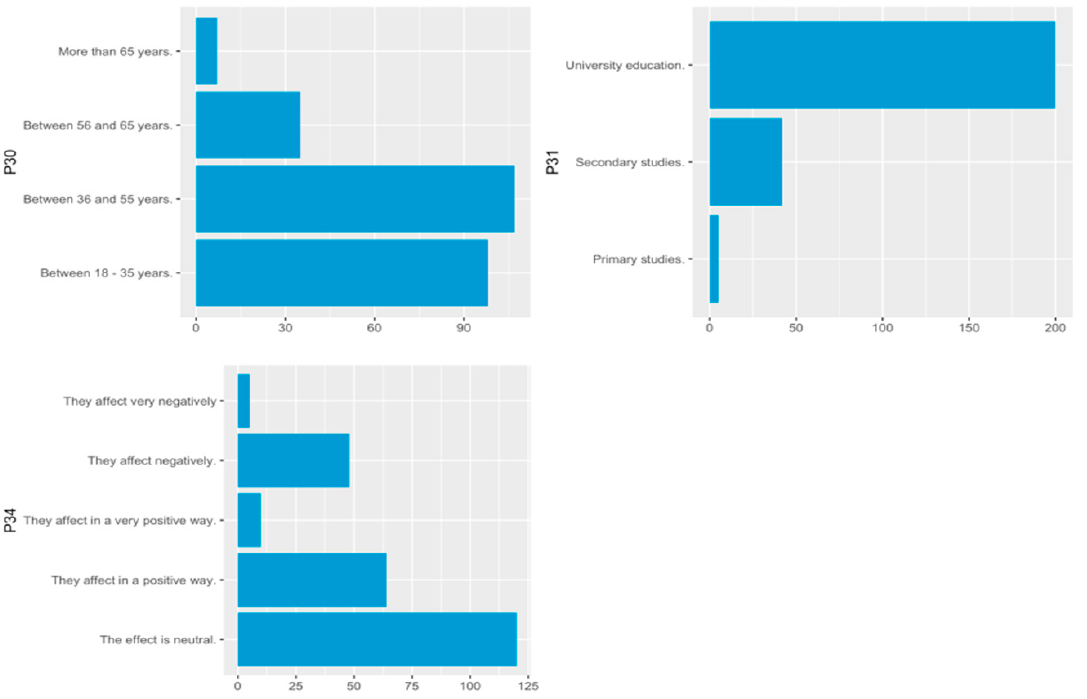
Figure 3. Summary of responses to questions with categorical responses from two categories. Source: compiled by the authors.